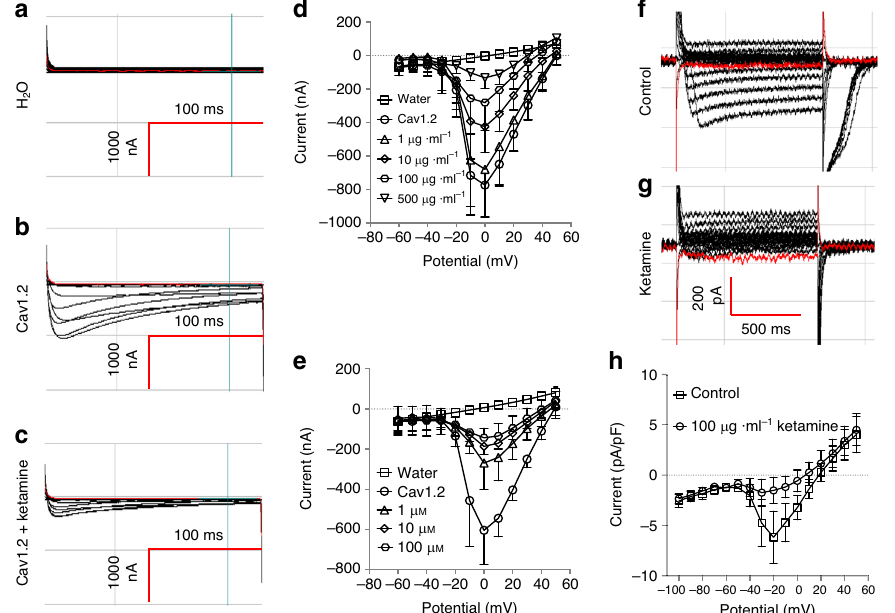
Fig. 4 Ketamine inhibits Cav1.2-mediated calcium channel activity. a – c are representative Ba 2 + current traces of two microelectrode voltage-clamped Xenopus oocytes, previously injected with water ( a , n = 5 oocytes) or with cRNA encoding Cav1.2 subunits, recorded in the absence ( b , n = 10 oocytes), or presence of ketamine ( c n = 10 oocytes). d , e summarize data from a – c showing dose-dependent inhibition of Cav1.2-mediated Ba 2 + current by ketamine ( d n = 10 oocytes) or nifedipine ( e n = 5 oocytes). f , g are representative whole cell current traces of fresh isolated BSM cells in the absence ( f n = 8 BSM cells) or presence ( g n = 8 BSM cells) of 100 µ g ml − 1 ketamine. h Summarizes data showing ketamine inhibition on Cav1.2-mediated Ba 2 + current in freshly isolated mouse BSM cells as shown in f , g . Data are presented as mean values ± SD. Source data are provided as a Source Data fi le.